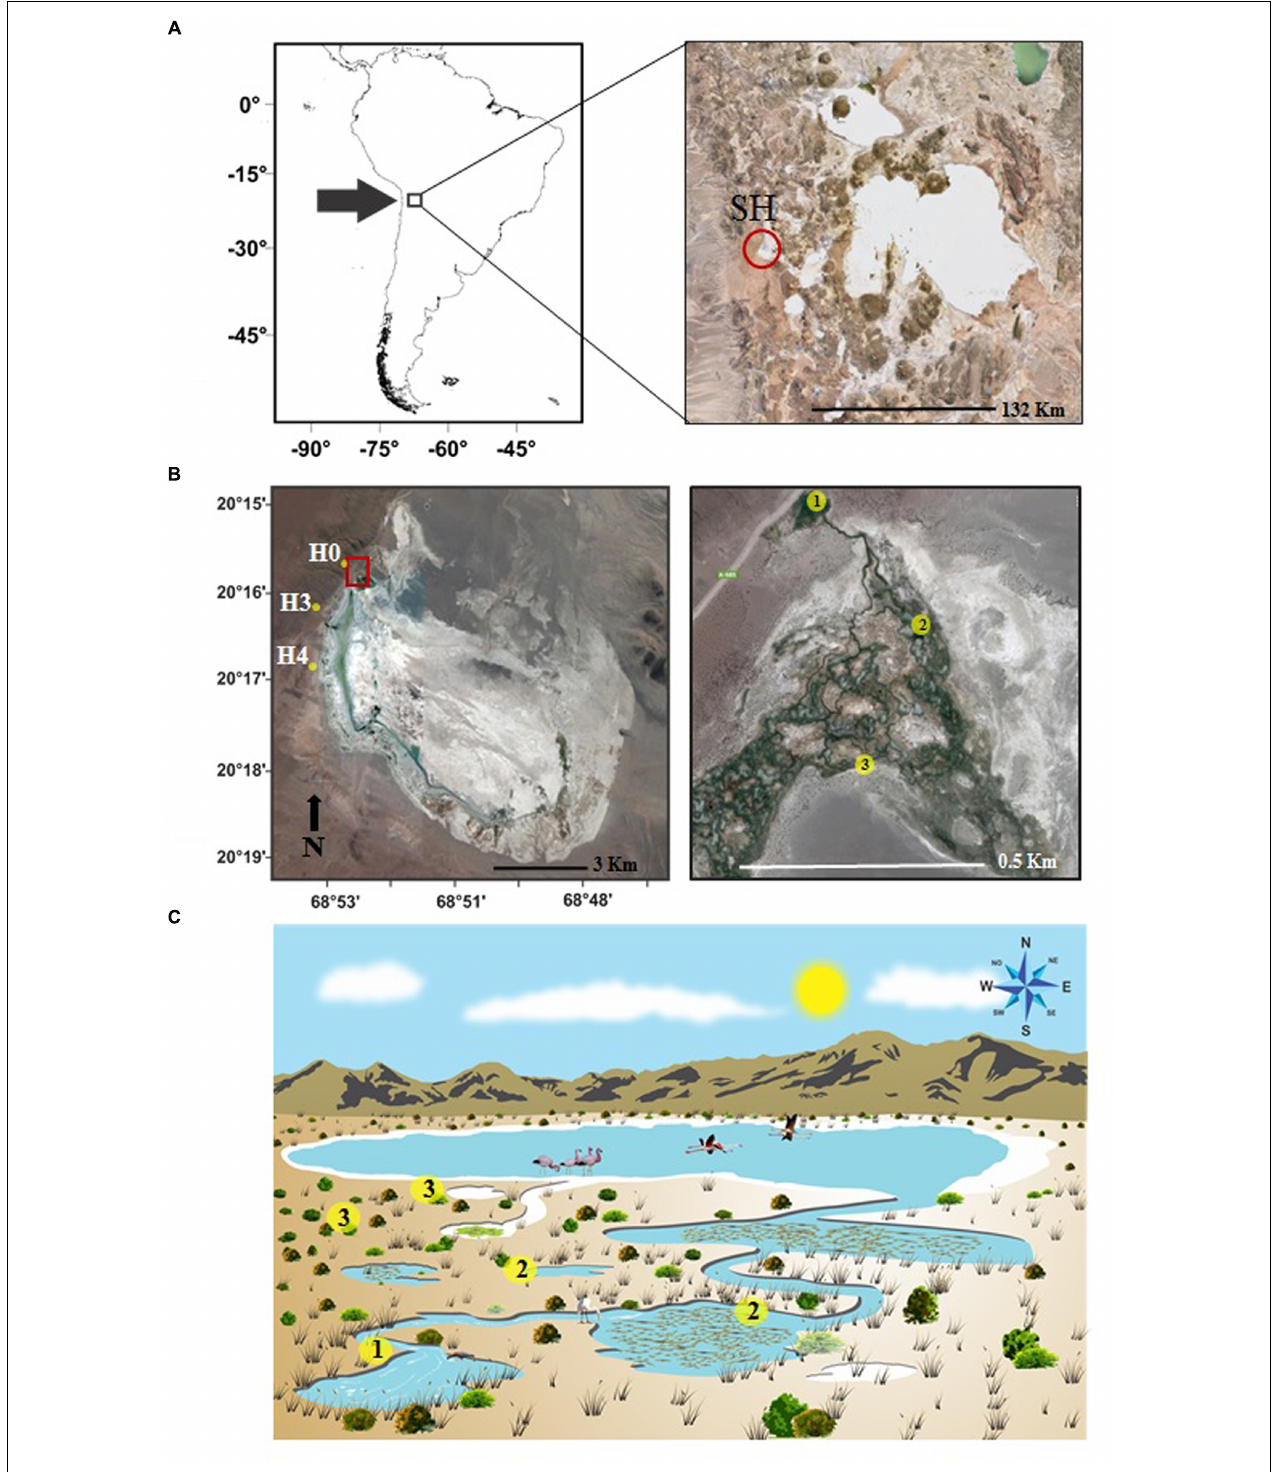
FIGURE 1 | (A) Location of the study area at Salar de Huasco (SH), Chile. (B) Distribution of sampled stations along Salar de Huasco on previously described subsystems H0, H3, and H4 (Dorador et al., 2008b). Details of the intricate water flow system are shown as station types: (1) ground sources stations, with no previous solar exposure, (2) running water and connected ponds stations, and (3) isolated ponds. (C) Conceptual diagram of the Salar de Huasco suggested for the water flow connectivity and microbial communities distribution: ground sources H0 and H3 represented by yellow circle (1), close and connected downstream stations H3-RW and H4-CP with yellow circle (2), isolated ponds closer to the main shallow lake with H3-IP, H4-IP, H4-VMP represented by yellow circle (3).